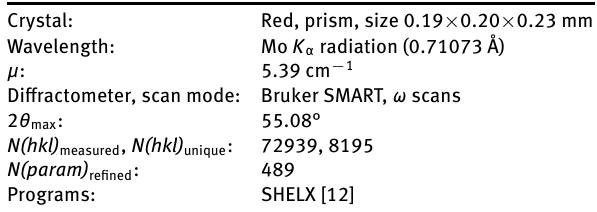
Table 2: Fractional atomic coordinates and isotropic or